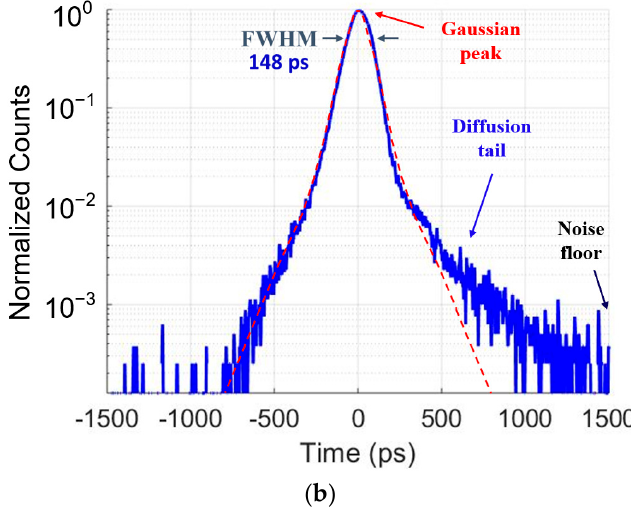
Figure 8. Timing ji tt er ( a ) Schematic diagram ( b ) An example of measured temporal response [97]. Figure 8. Timing jitter ( a ) Schematic diagram ( b ) An example of measured temporal response